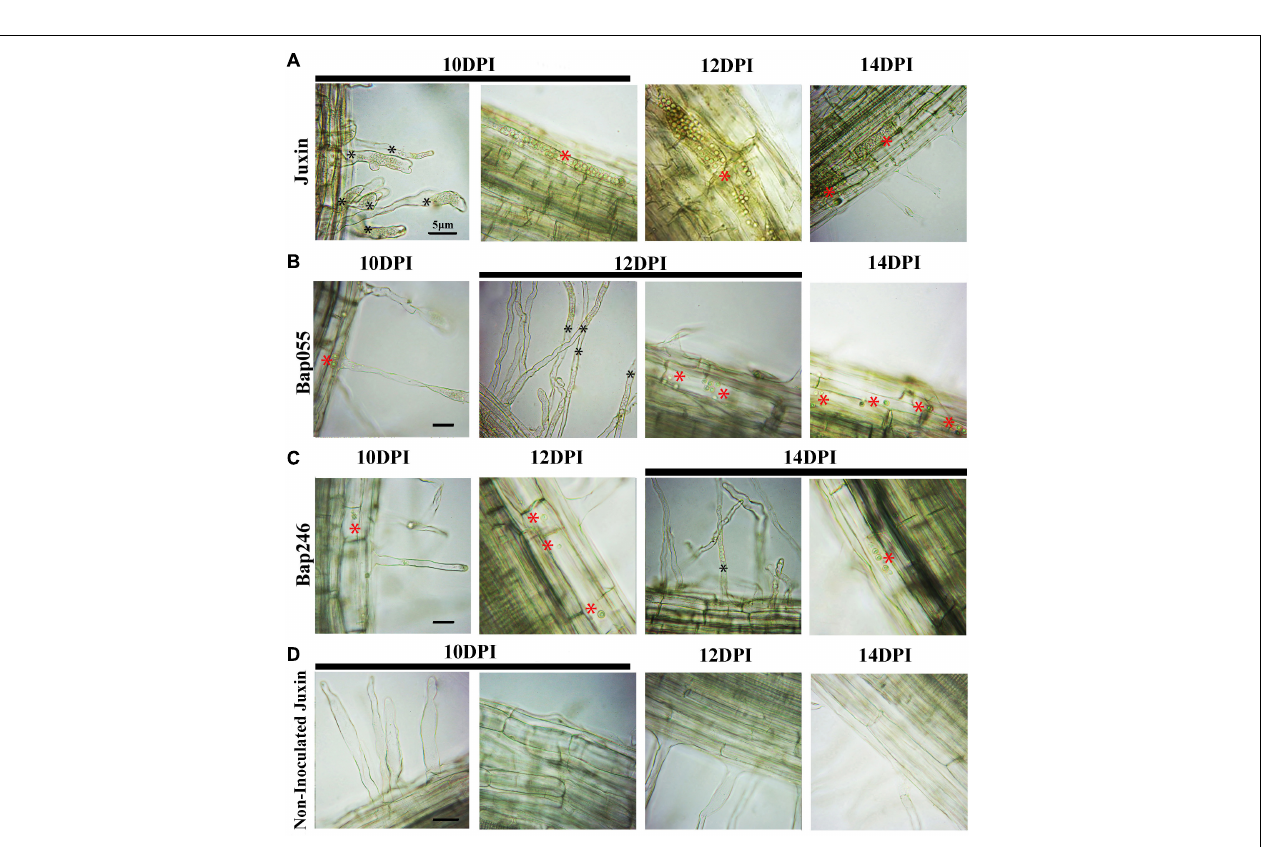
Frontiers in Plant Science |